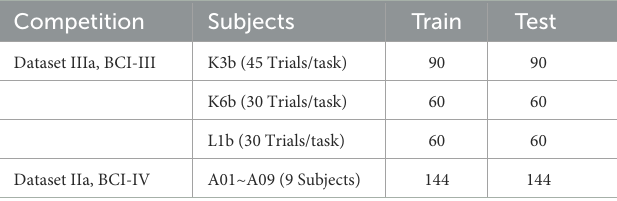
TABLE 2 Data description.